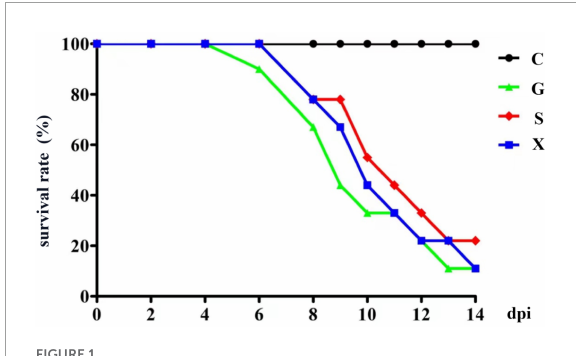
FIGURE1 The survival rate of mice with reactivation of Toxoplasma gondii infection. C: no T. gondii + DEX + PBS; G: 3 T. gondii cysts + DEX + PBS; S: 3 T. gondii cysts + DEX + koumiss; X: 3 T. gondii cysts + DEX + mare’s milk. All data are expressed as mean ±